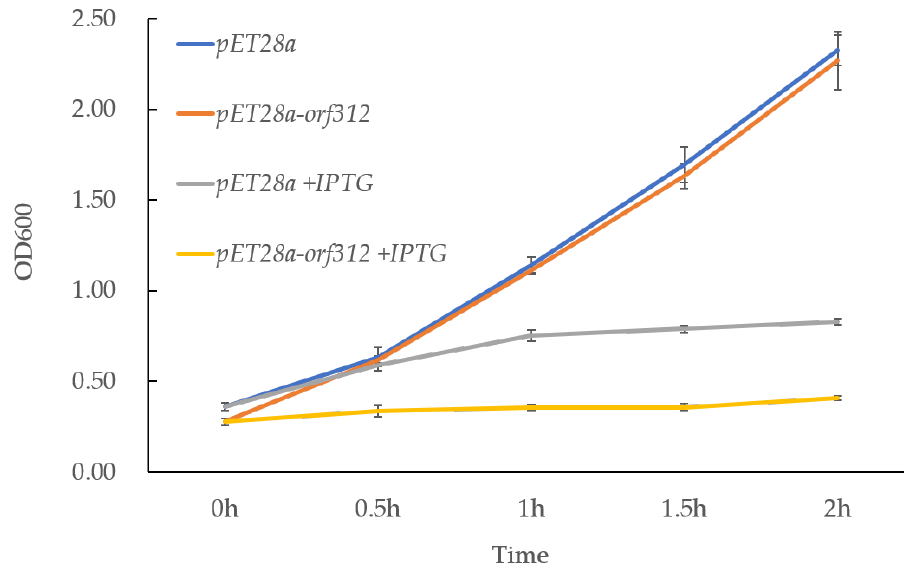
Figure 6. ORF312 expression in E. coli: cell growth in culture with or without IPTG induction. Cell density was determined at various time points for OD600. Cell were cultured at 37 ◦ C. Data are presented as mean ± SD in triplicate.